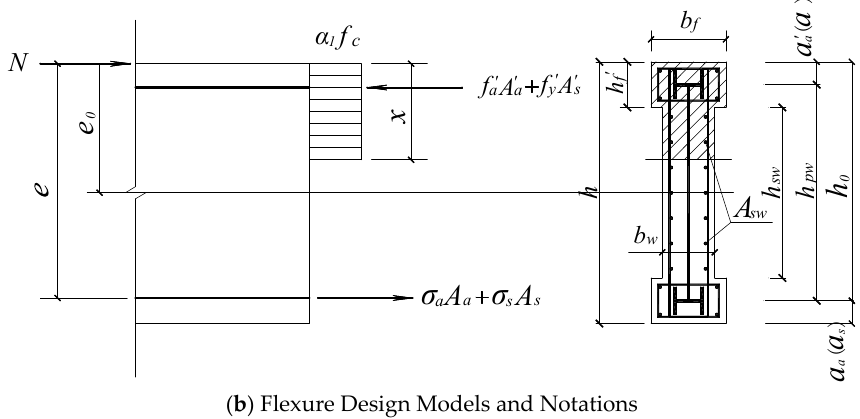
Figure 19. Flexure Design Models Developed based on Plane Section Assumption.